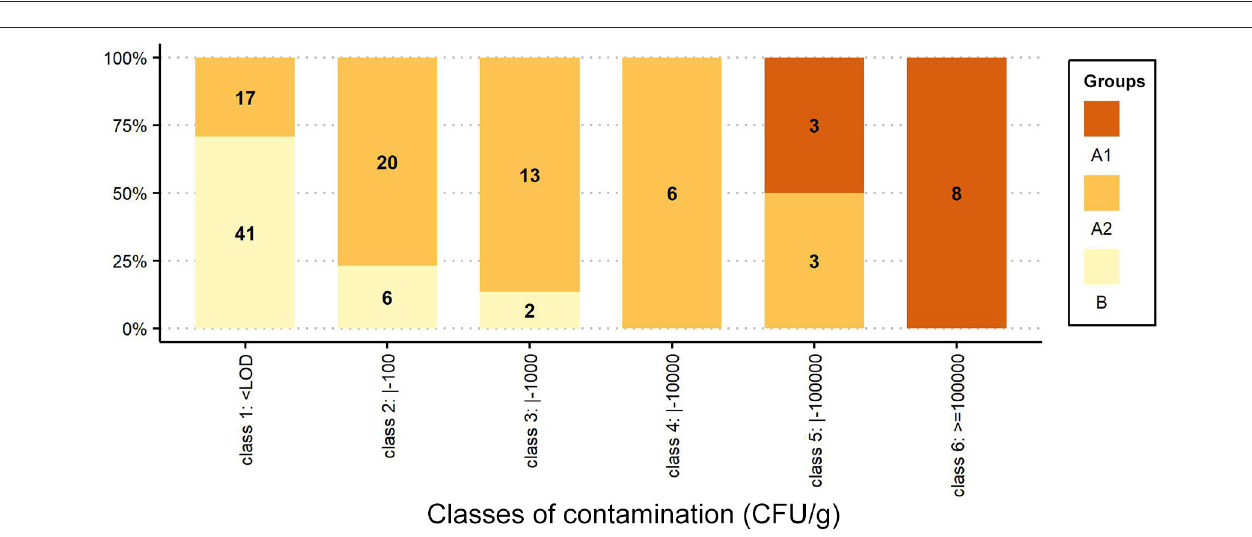
FIGURE 1 | Boxplot of the distribution of P. larvae spore contamination classes (CFU/g) in powdered sugar samples for different groups (A1, colonies with clinical symptoms of AFB; A2, colonies without clinical symptoms of AFB located in apiaries with colonies showing symptoms of AFB; and B: colonies from apiaries with no cases of AFB in the last years-control group).